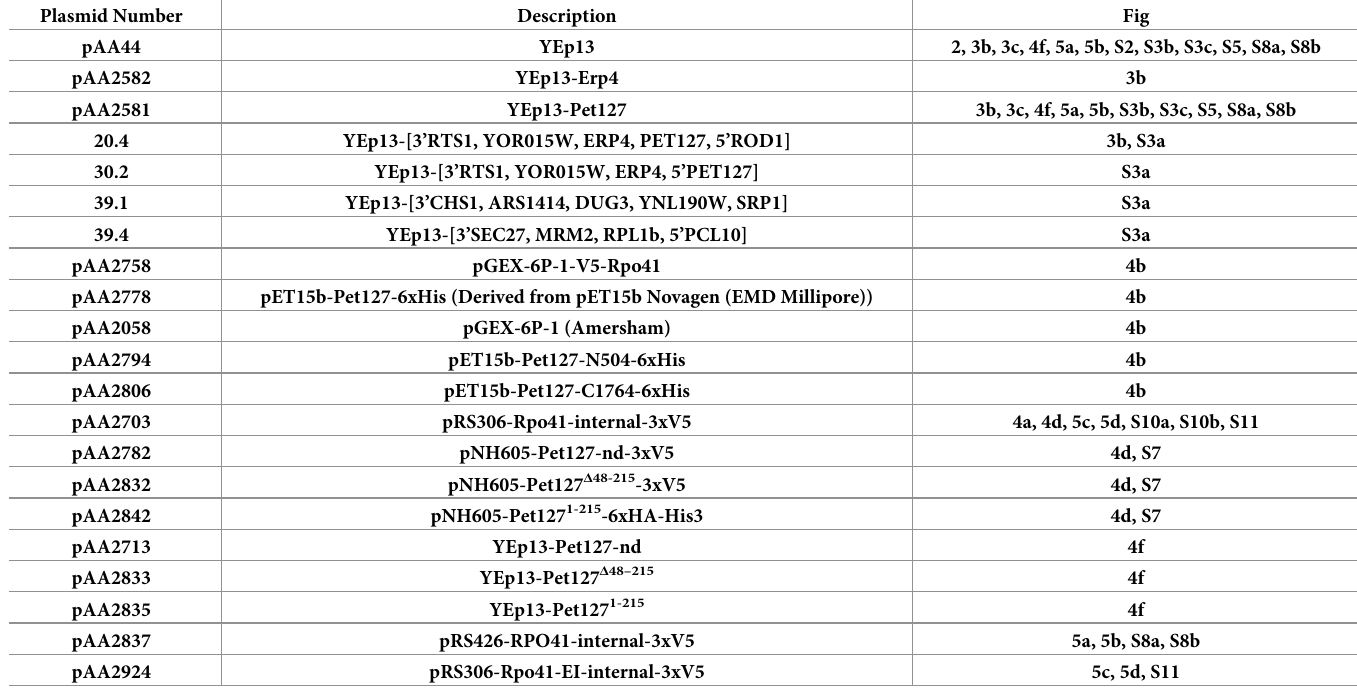
Table 2. List of Plasmids Used in this Study.